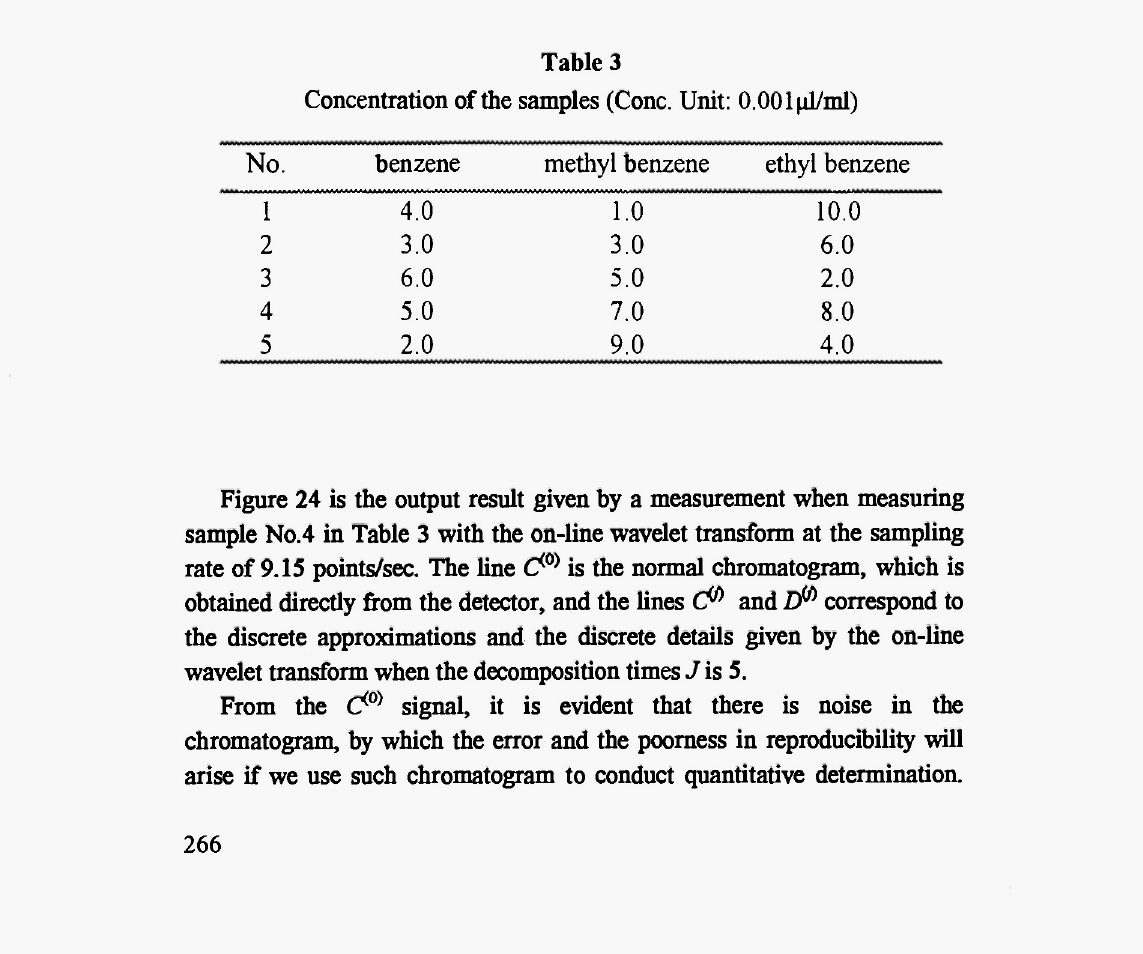
Concentration of the samples (Cone. Unit: Ο.ΟΟΙμΙ/ml) methyl